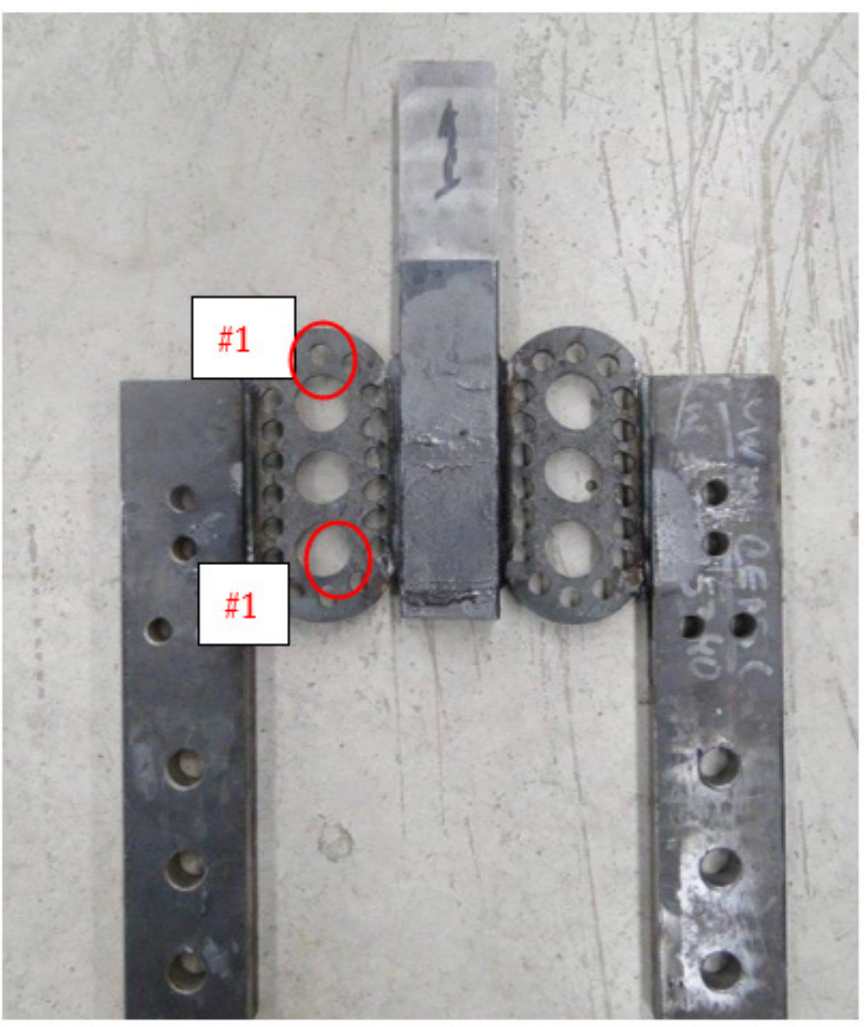
Figure 13. Failure mode of MYZ-1.